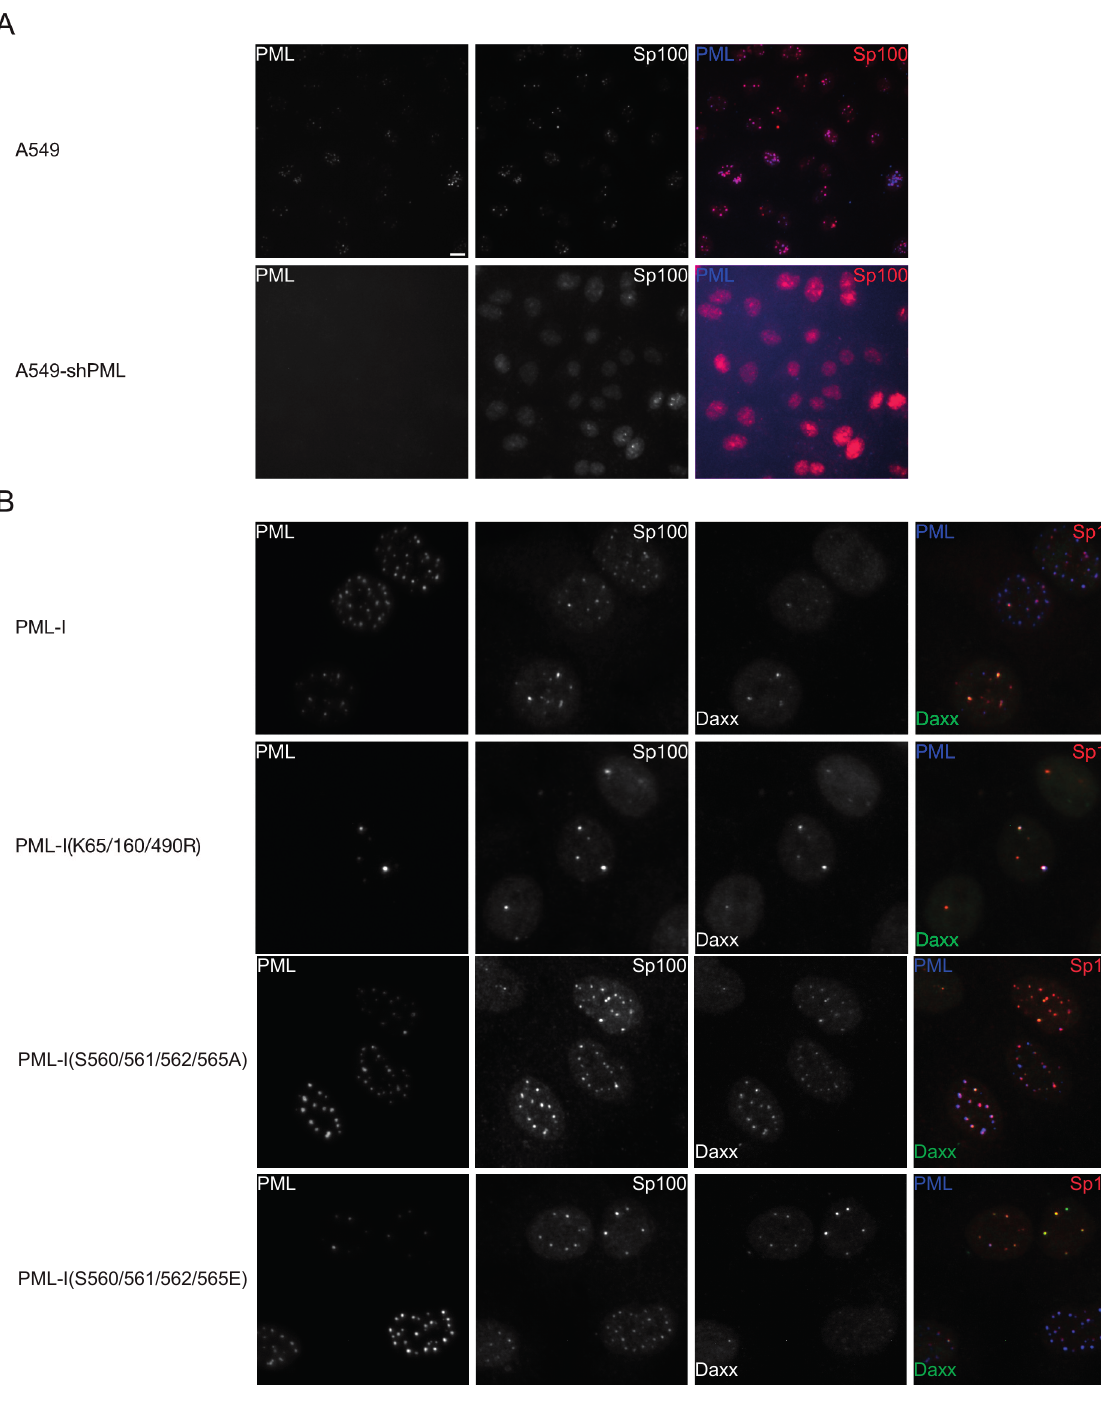
Figure 2. Phosphorylation sites near the SIM control ND10 size and number. Recruitment of Sp100 and Daxx to PML-I and PML-I phosphorylation mutants in PML-depleted A594 cells. ( A ) A549 or A549 cells that express an shRNA that targets PML (A549-shPML) and stained for PML and Sp100 by immunofluorescence. ( B ) A549-shPMLs were transduced